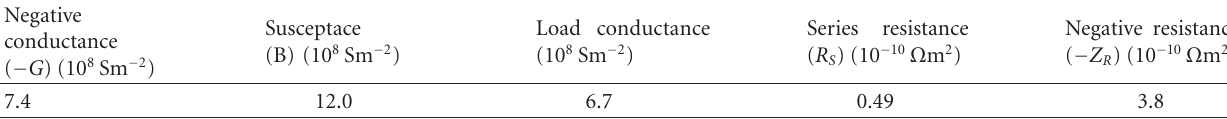
Figure 5: (a) E ff ect of electron dominated photo-current on negative resistivity profile of 4H-SiC DDR IMPATT diode. (b) E ff ect of hole dominated photo-current on negative resistivity profile of 4H-SiC DDR IMPATT diode. Table 3: Series resistance of 4H-SiC IMPATT at 0.7